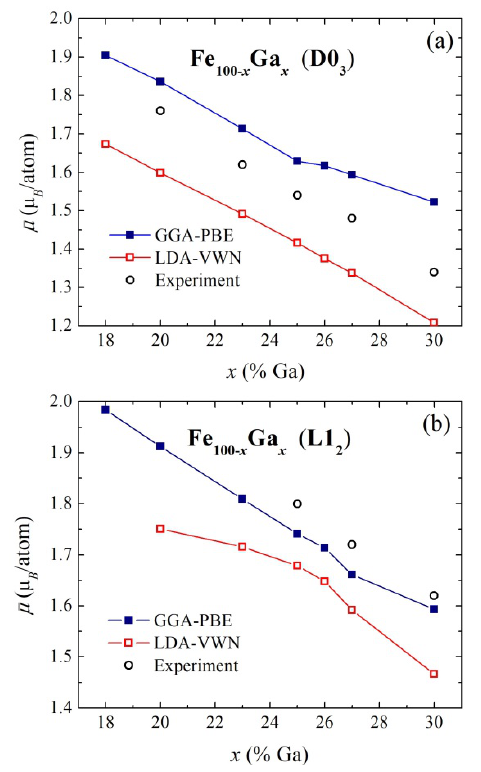
Fig. 2. The calculated total magnetic moment μ B / atom) as a function of Ga concentration ( x ) for the (a) (a) D0 3 and (b) L1 2 crystal structures of Fe 100- x Ga x alloys in comparison with experimental data. The experimental data were taken from [8].